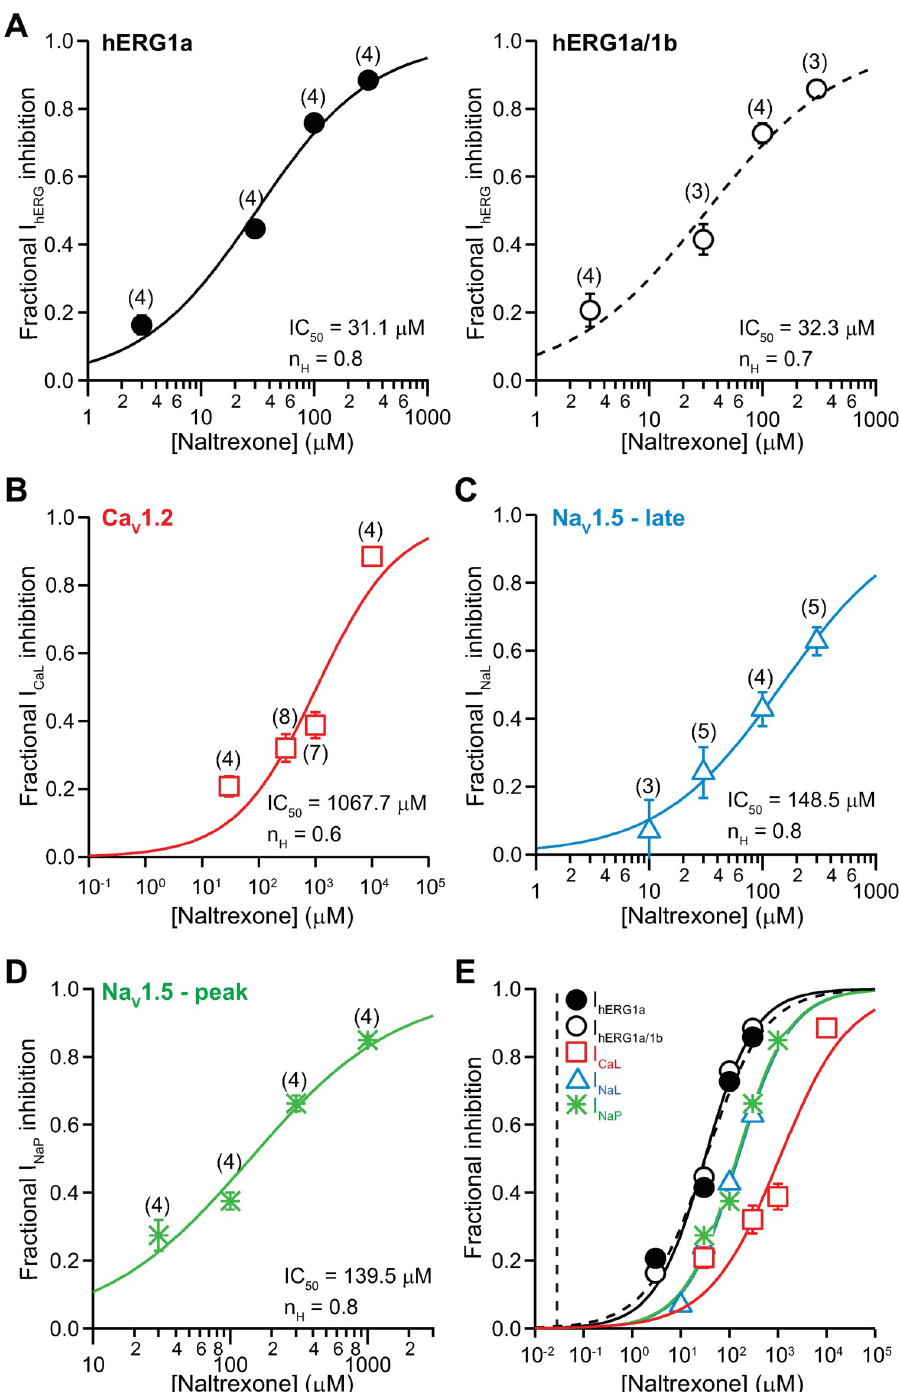
Fig 6. Effects of naltrexone. Concentration-inhibition plots of naltrexone on I hERG (A) , I CaL (B) , I NaL (C) , and I NaP (D) . E) An overlay of concentration-inhibition curves for all studied currents. The vertical dashed line indicates free C max of 0.028 μ